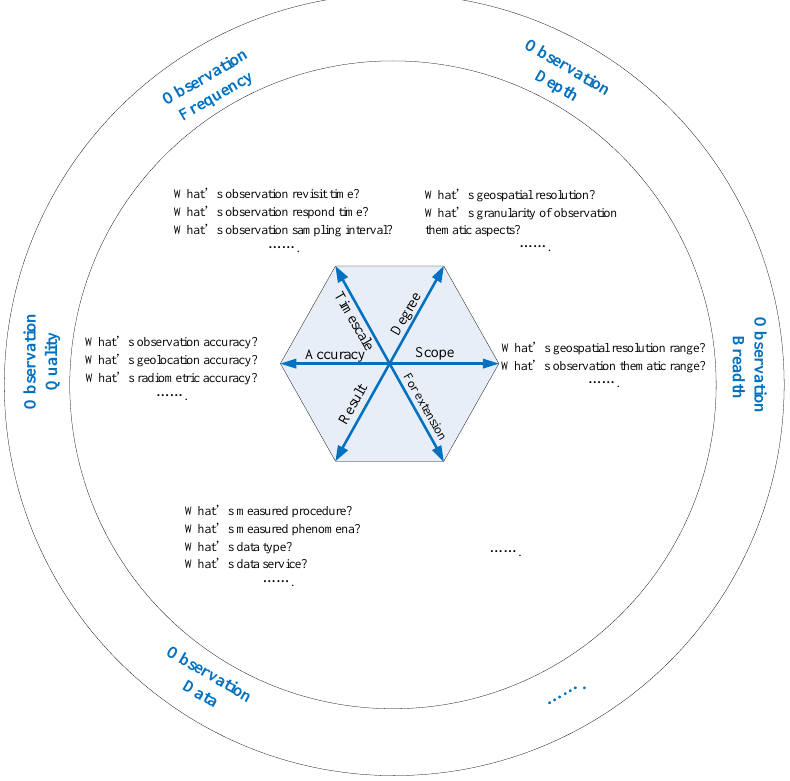
Figure 2. Design pattern of the proposed metadata model